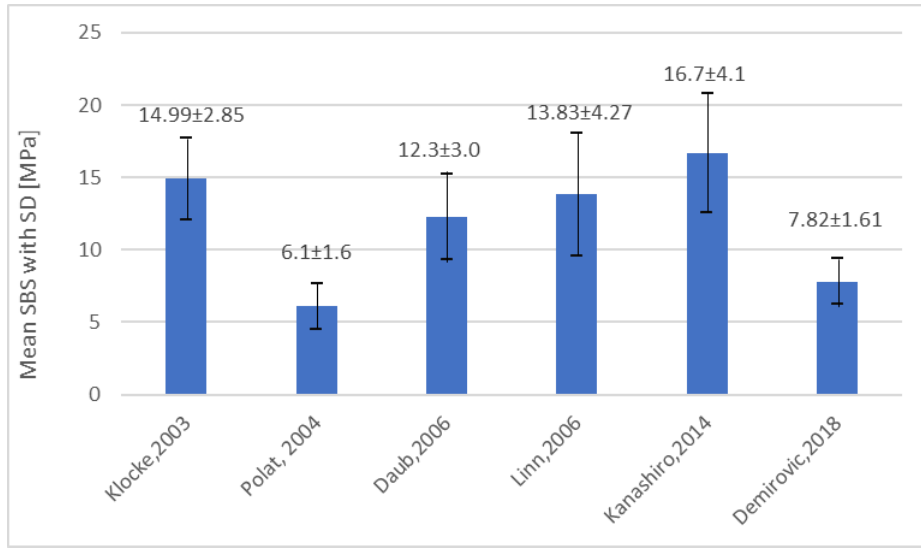
Figure 3. SBS of Sondhi’s Rapid Set in different articles.